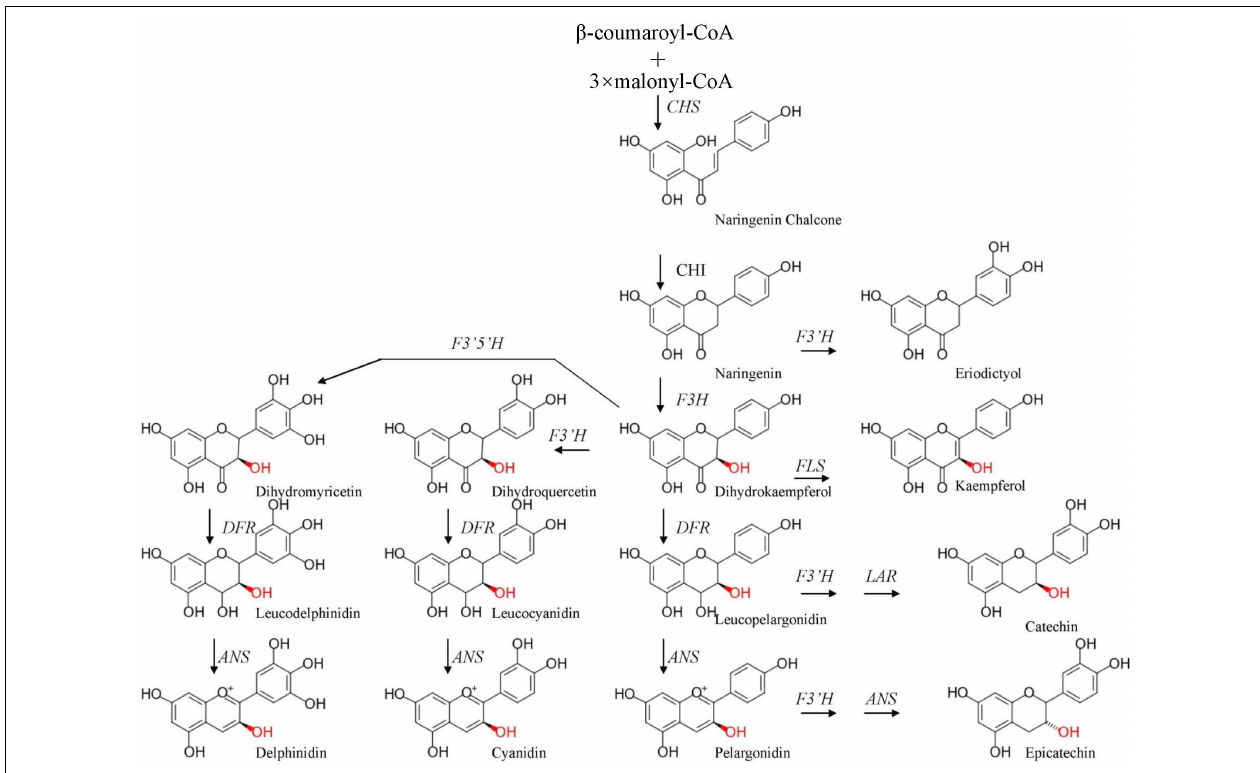
FIGURE 1 | Simplified model of the flavonoid pathway, comprising the general phenylpropanoid pathway, the anthocyanin branch, and other subgroups of flavonoid end products. CHS, chalcone synthase; F3H, flavanone 3-hydroxylase; DFR, dihydroflavonol-4-reductase; ANS, anthocyanidin synthase; F3 (cid:48) H, flavonoid 3 (cid:48) -hydroxylase; FLS, flavonol synthase; F3 (cid:48) 5 (cid:48) H, flavonoid 3 (cid:48) ,5 (cid:48) -hydroxylase; LAR, leucoanthocyanidin